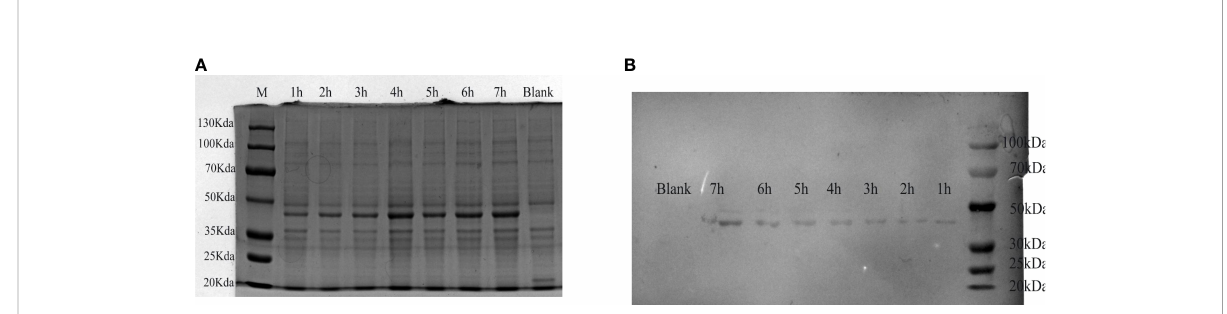
FIGURE 1 Analysis of expression products of E. coli BL21/pET-32a- tCap . (A) Visual analysis of protein by 12% SDS-PAGE. Line M, protein marker; line 1-7, expression product after adding IPTG for 1-7h; line 8: blank control. (B) Western blot analysis of transmembrane